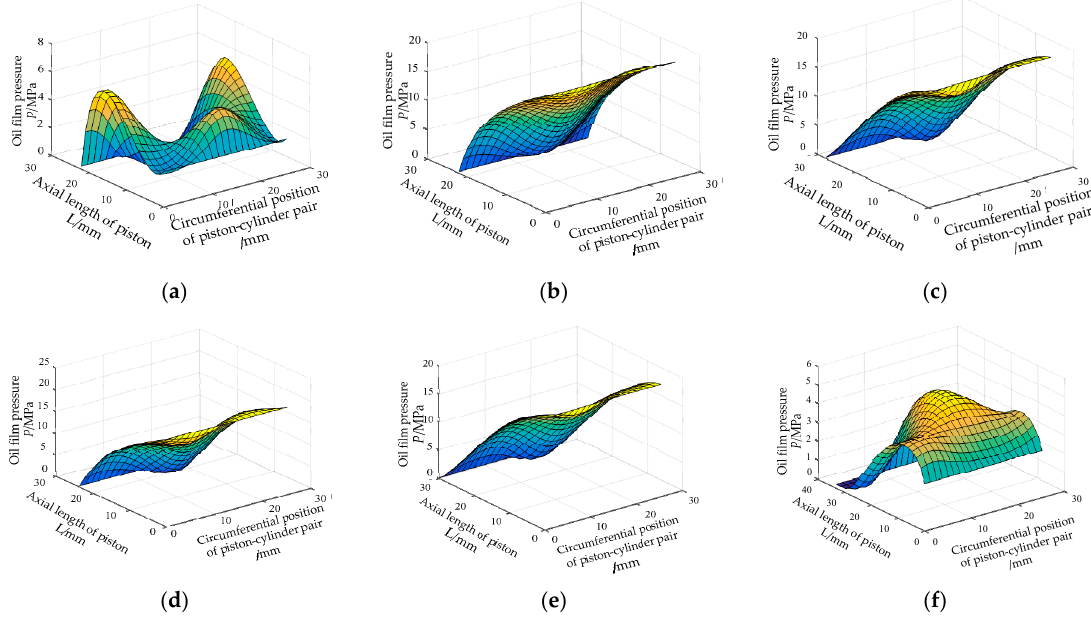
Figure 7. The figure shows the distribution of oil film pressure at different inclined plate rotation angles under constant pressure conditions: ( a ) Oil film pressure distribution with swashplate rotation of 1°; ( b ) oil film pressure distribution with swashplate rotation of 10°; ( c ) oil film pressure distribution with swashplate rotation of 45°; ( d ) oil film pressure distribution with swashplate rotation of 90°; ( e ) oil film pressure distribution with swashplate rotation of 110°; ( f ) oil film pressure distribution with swashplate rotation of 210°.